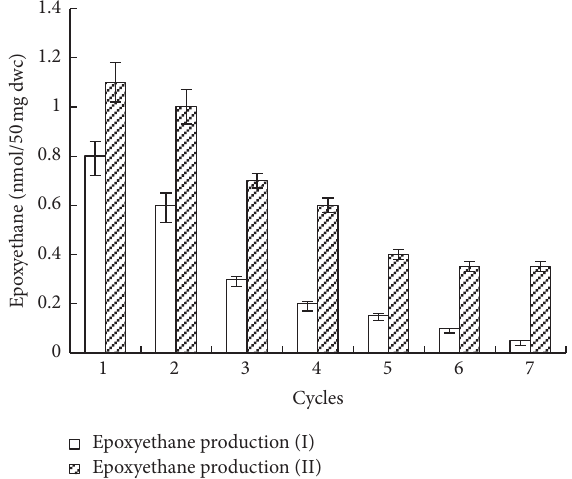
Figure 5: Repetitive batch epoxyethane production with Methy- losinus trichosporium IMV 3011. The repetitive batch epoxidation experiments were conducted as described in the text. The above procedure was repeated seven times. (I) Ethylene 20%, oxygen 50%, and nitrogen 30%. (II) Ethylene 20%, oxygen 50%, methane 10%, and nitrogen